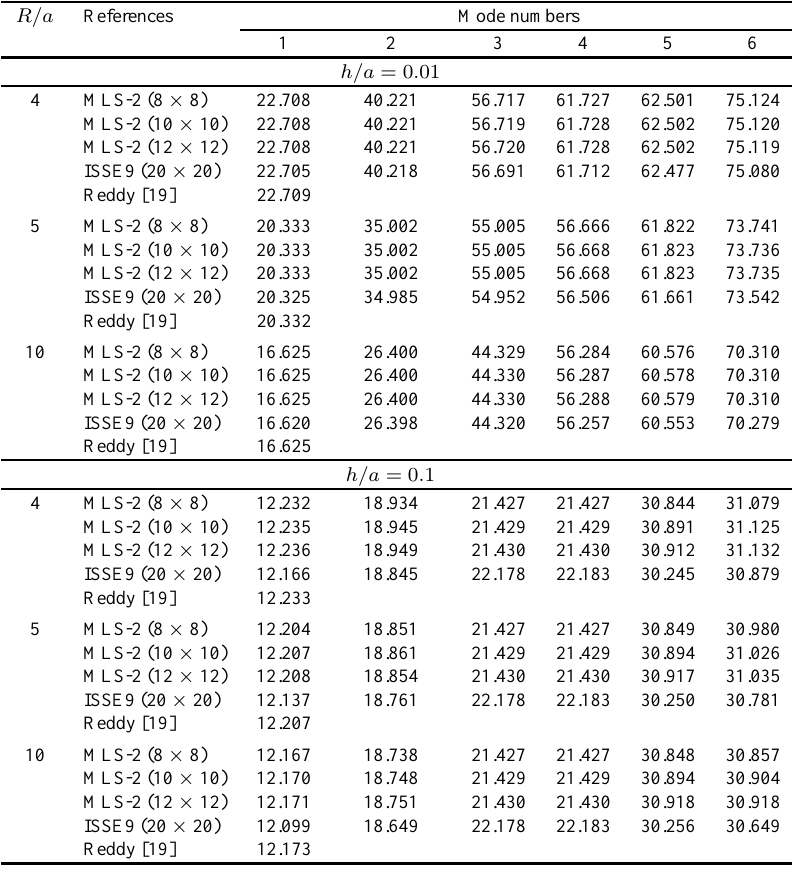
(cid:1) Table 4 ρ/E 2 h 2 ) of a cross-ply (0/90/0) cylindrical shell panel (Fig.